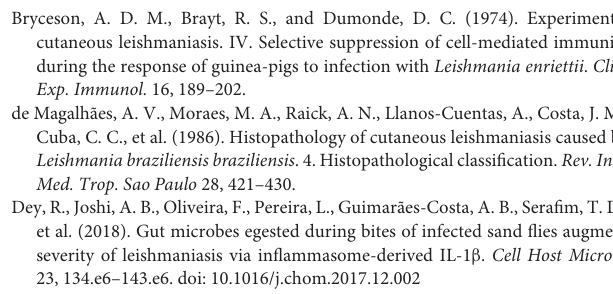
FIGURE S1 | Negative controls of histological (HE) and immunohistochemistry (IHC) of nasal areas of C. porcellus. (A) Inoculated with saline, (B) inoculated with SGE, (C) uninfected animal, (D) inoculated with saline (negative control for amastigote labeling), and (E) inoculated with saline (negative control for L1 and CD163